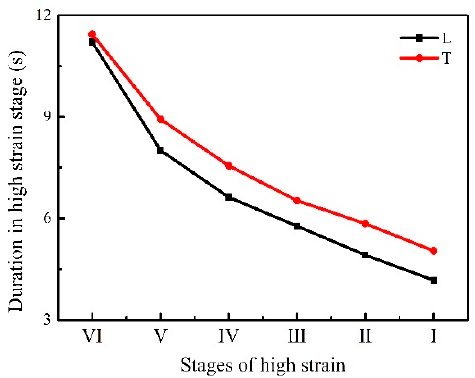
Figure 15. Comparison of the duration in high strain stages between the transversal and longitudinal specimen. T—Transversal specimen; L—longitudinal specimen. ( a ) Transversal specimen; ( b ) longitudinal specimen.